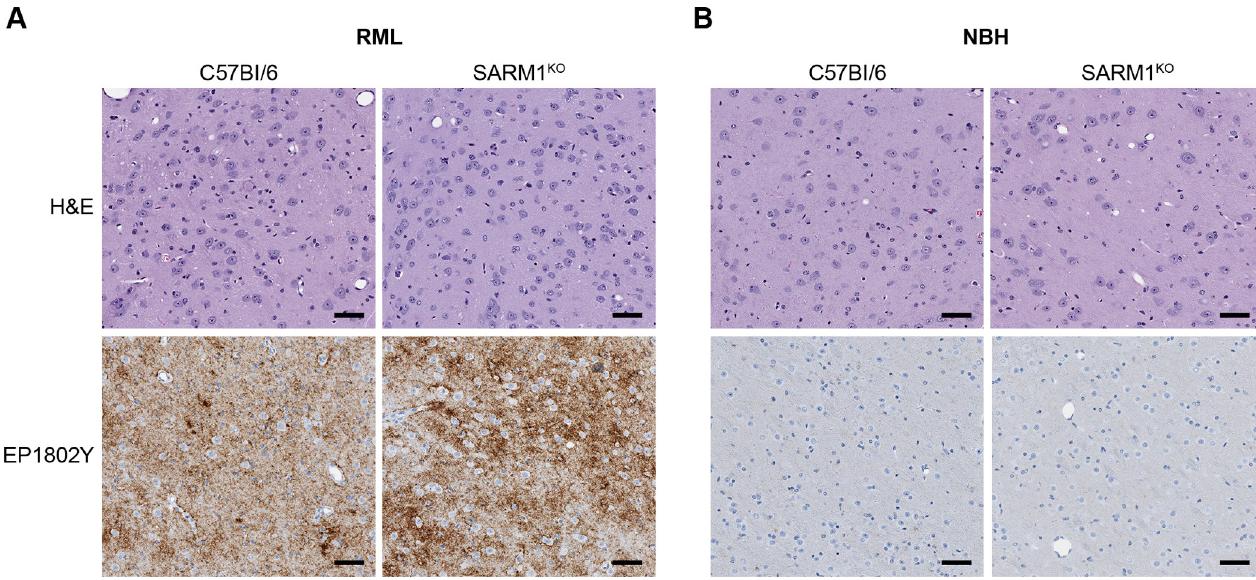
Fig 1. PrP Sc deposition and spongiform change in the brain are similar in SARM1 KO and C57Bl/6 mice 75 days after intracranial inoculation with RML prions. (A) H&E and PrP Sc staining for C57Bl/6 (left panels) and SARM1 KO (right panels) in the thalamus of mice 75 DPI after inoculation intracranially with RML prions. (B) H&E and PrP Sc staining for C57Bl/6 (left panels) and SARM1 KO (right panels) in the thalamus of mice 75 DPI after inoculation intracranially with normal brain homogenate (NBH). PrP Sc was detected using the anti-PrP rabbit monoclonal antibody EP1802Y as described in the materials and methods. For all panels, scale bar = 50 μ m.